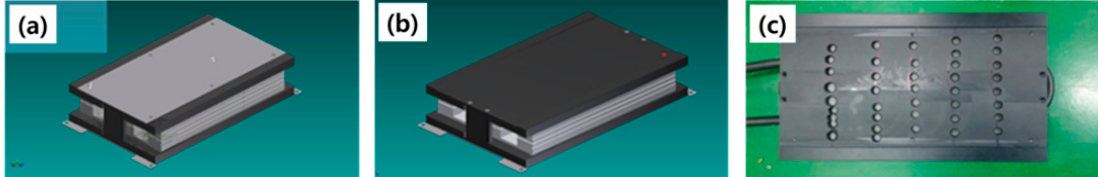
Figure 4. Three candidates of modified pickup modules to enhance thermal performance: ( a ) Module A, ( b ) module B, and ( c ) module C.